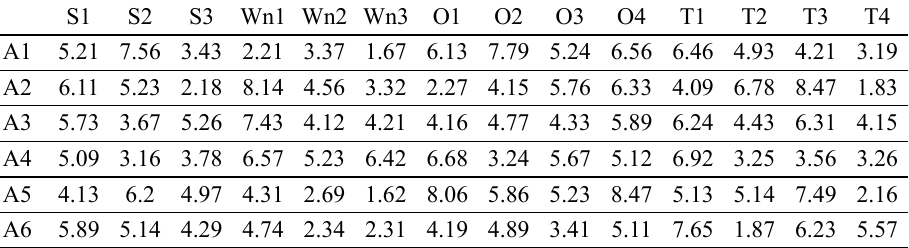
Table 10. Important rating of each alternative